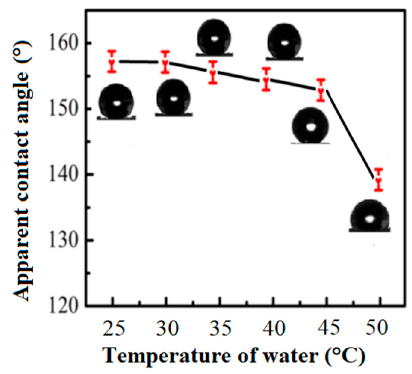
Figure 6. The apparent contact angles with di ff erent temperatures of immersion water.